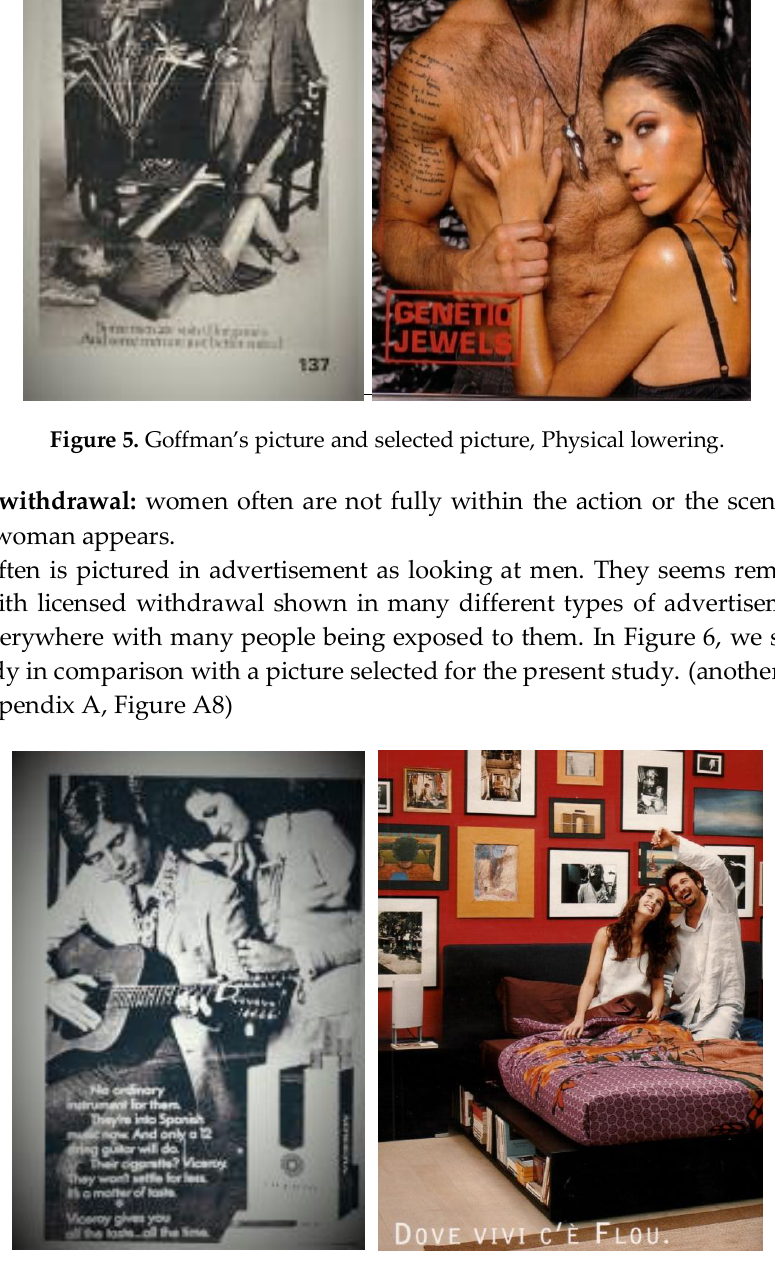
Figure 6. Goffman and selected picture, men behave, women